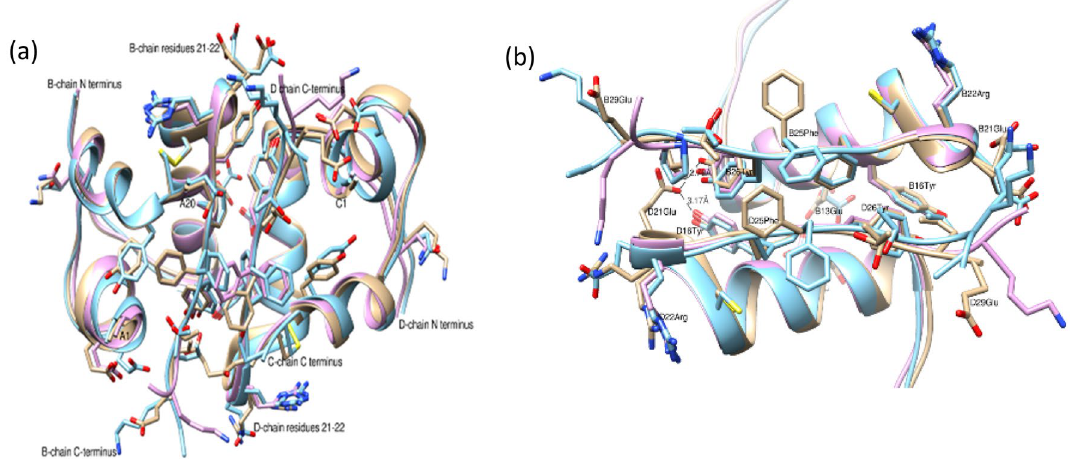
Figure 3. ( a ) The overall superposition of IGlu (tan) and human insulin 4INS (light blue) and 4EY9 (purple). Main differences are observed at the C-terminal of B/D chains and at D-chain residues 21–22. ( b ) A zoom along the two fold symmetry and the unique hydrogen bonds of D21Glu to B26Tyr and D16Tyr OH. Figure created using Chimera v1.8.1 http://www.cgl.ucsf.edu/chime